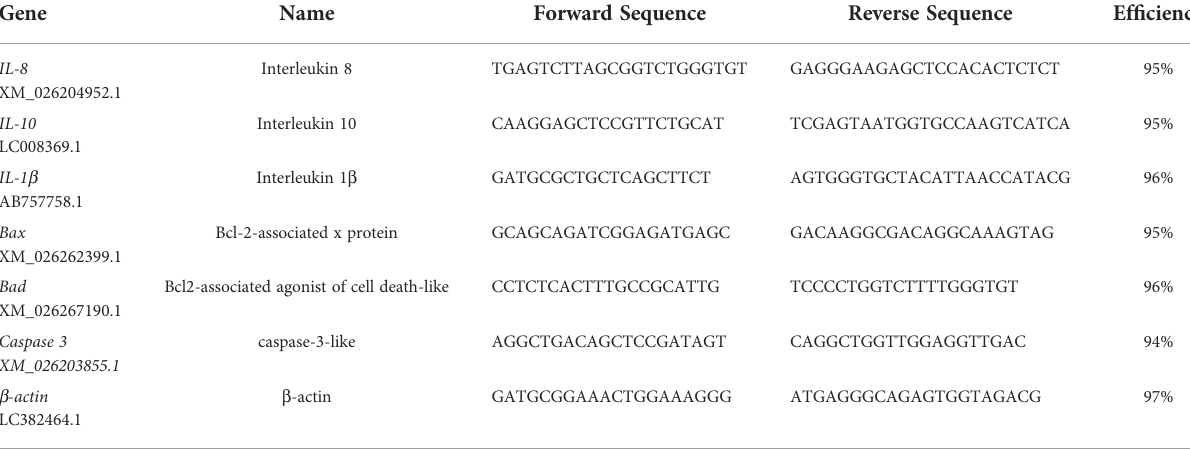
TABLE 1 Primers used for gene expression analysis by qRT-PCR in gill of gold fi